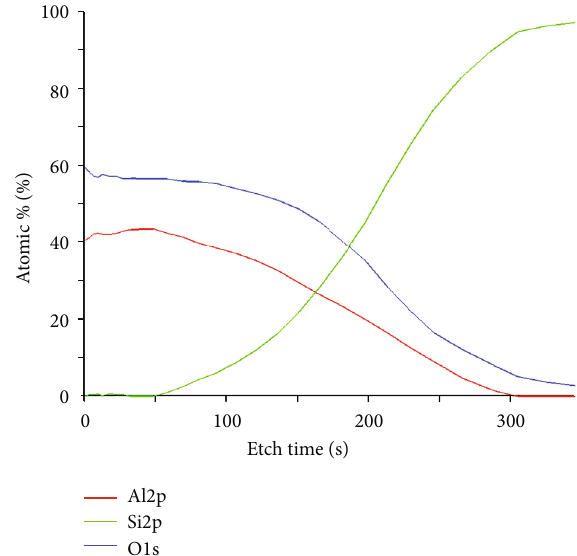
Figure 5: EDS analysis for a sample with the stack of Al after annealed at 600 ° C for 90 seconds.